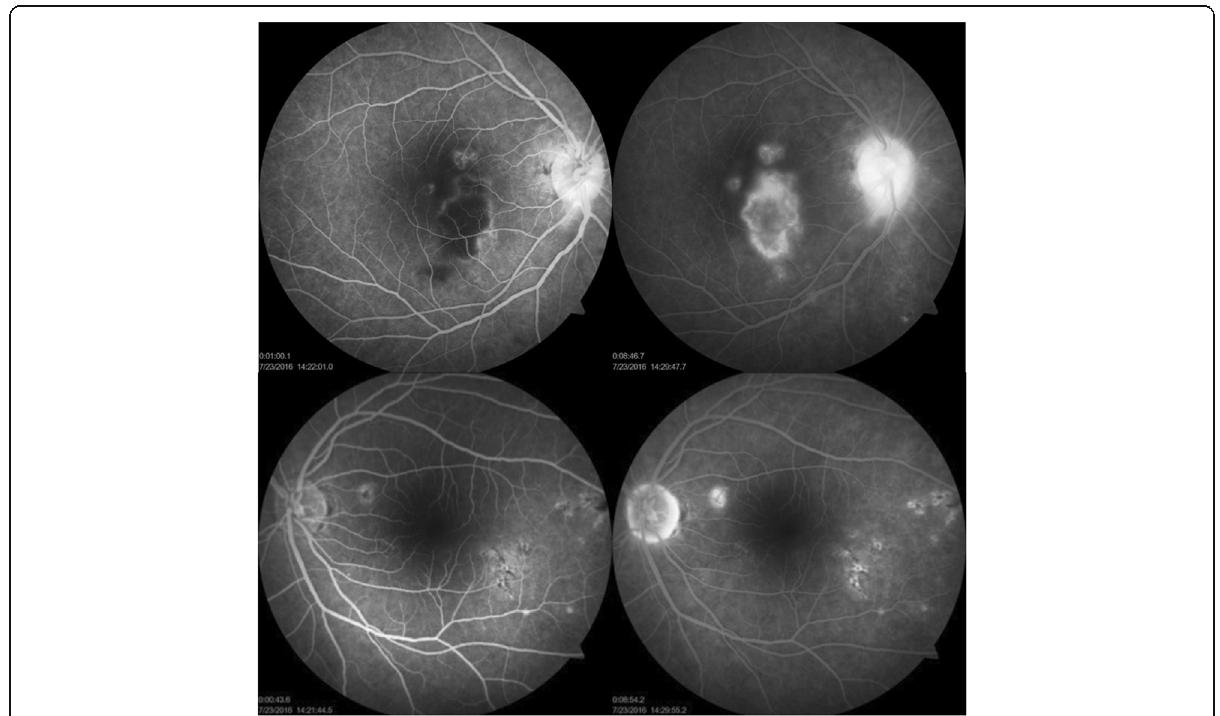
Fig. 2 FFA in the right eye showed presence of three hypofluorescent lesions in posterior pole in early frames with progressively increasing hyper fluorescence in late frames due to leakage. Significant disc leakage is also noted. In the left eye , similar smaller hypofluorescent lesion is noted along papillomacular bundle with early central hypoflorescence and later hyperfluorescence. Area of stippled fluorescence was noted inferotemporal to macula with staining in late frames. Minimal disc leakage was also noted in the left